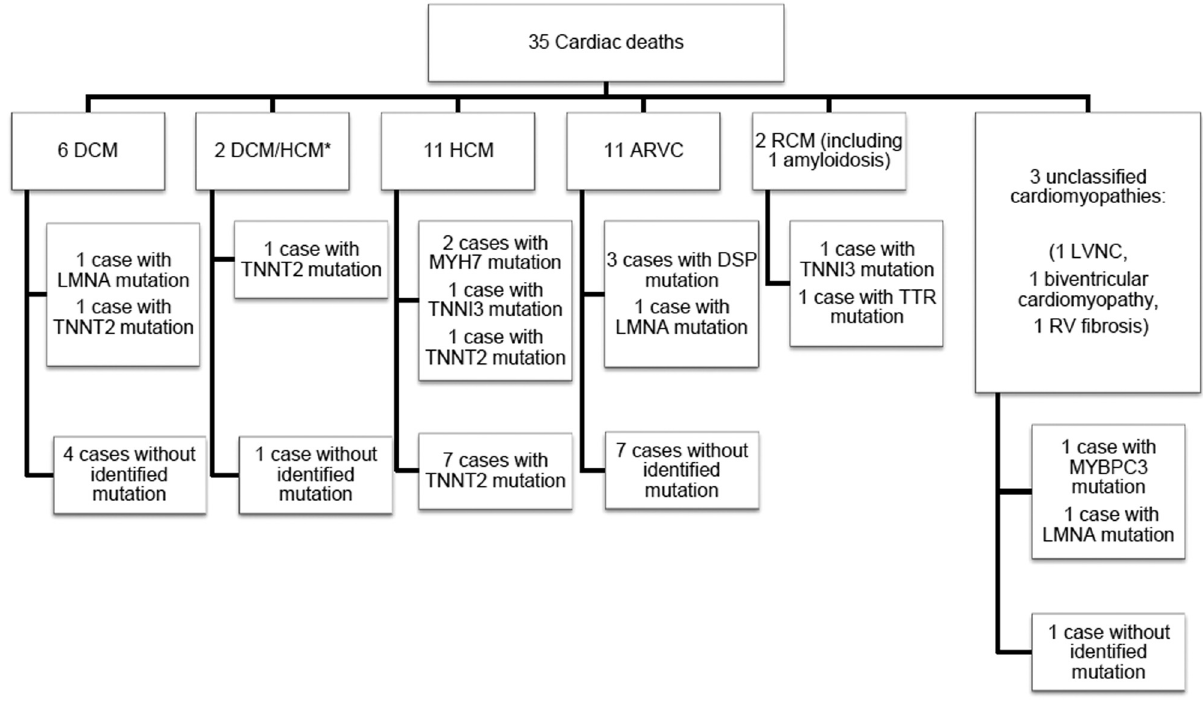
Figure 1: Overview of all patients according to the suspected cardiomyopathy. ARVC: arrhythmogenic right ventricular cardiomyopathy, HCM: hypertrophic cardiomyopathy, DCM: dilated cardiomyopathy, RCM: restrictive cardiomyopathy, LVNC: left ventricular non - compaction. *HCM/DCM: HCM observed in the deceased but DCM previously reported in a relative, subsequently interpreted as end - stage form of